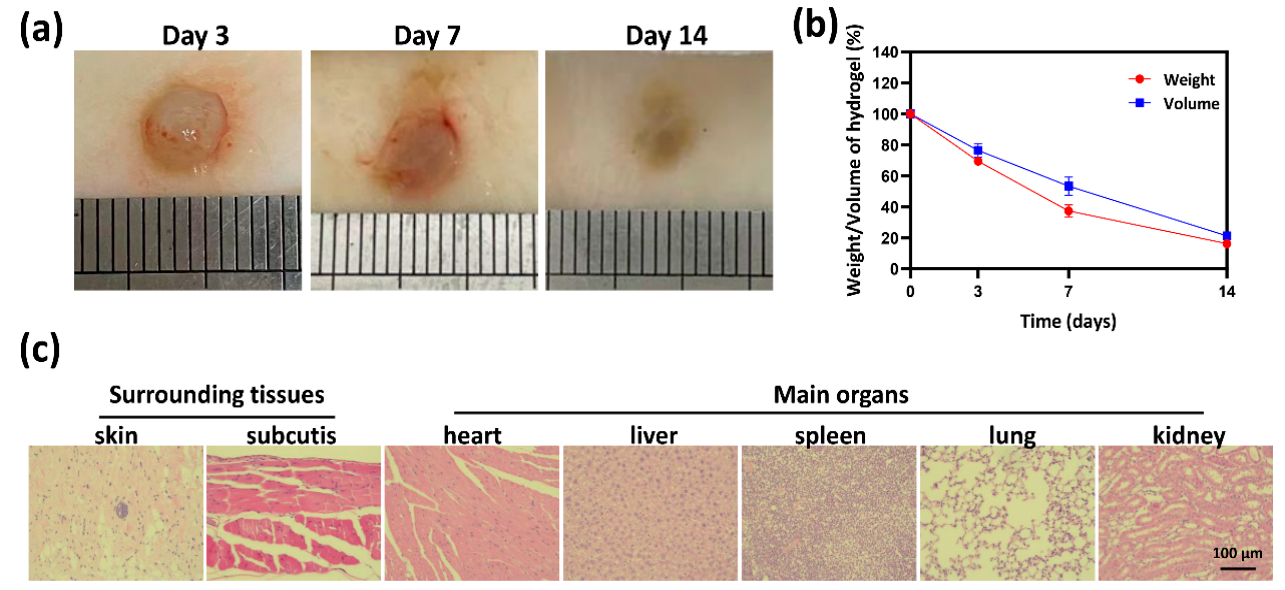
Figure 7. Morphology ( a ) and degradation rate ( b ) of hydrogels in Kunming mice. ( c ) HE staining of surrounding tissues and main organs (heart, liver, spleen, lung, and kidney) on the fourteenth day. Mean ± SD, n = 3.